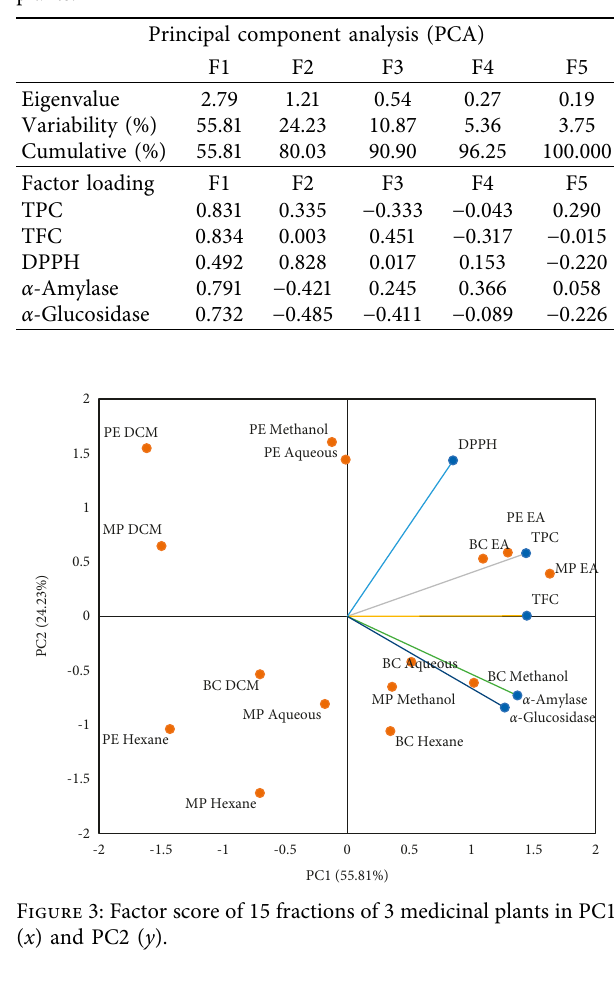
Table 7: Principal component analysis for phytochemical content and pharmacological activities of different extracts of selected plants.